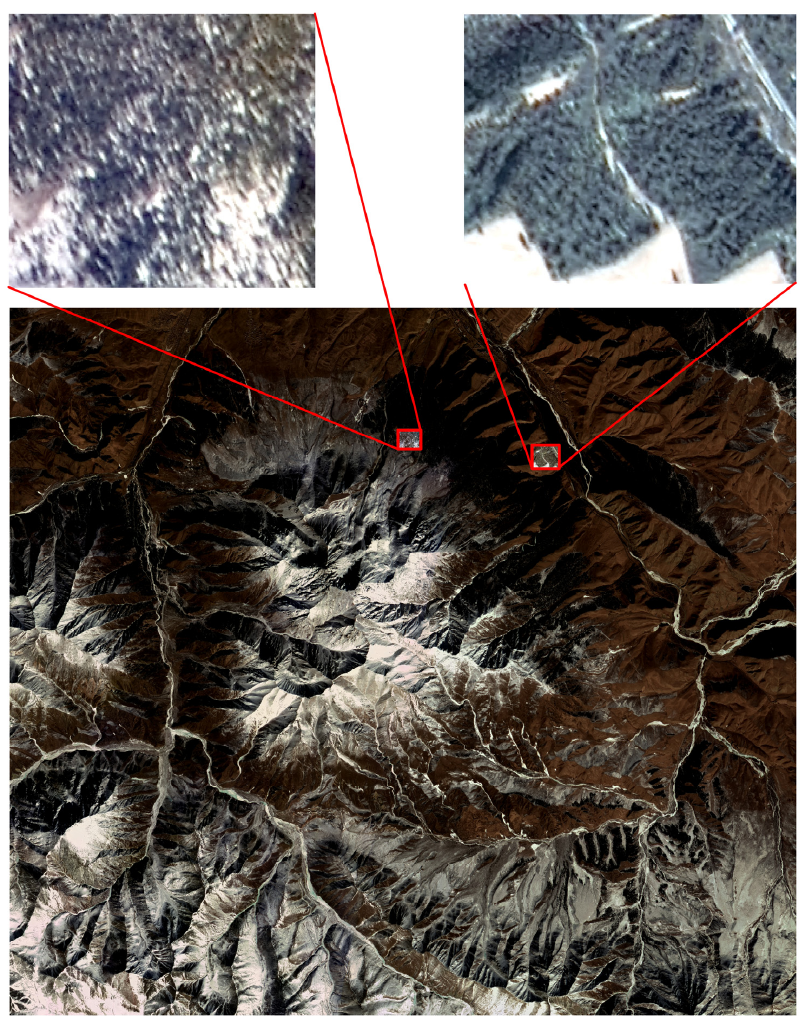
Figure 7. GF-1 image used for accuracy evaluation.